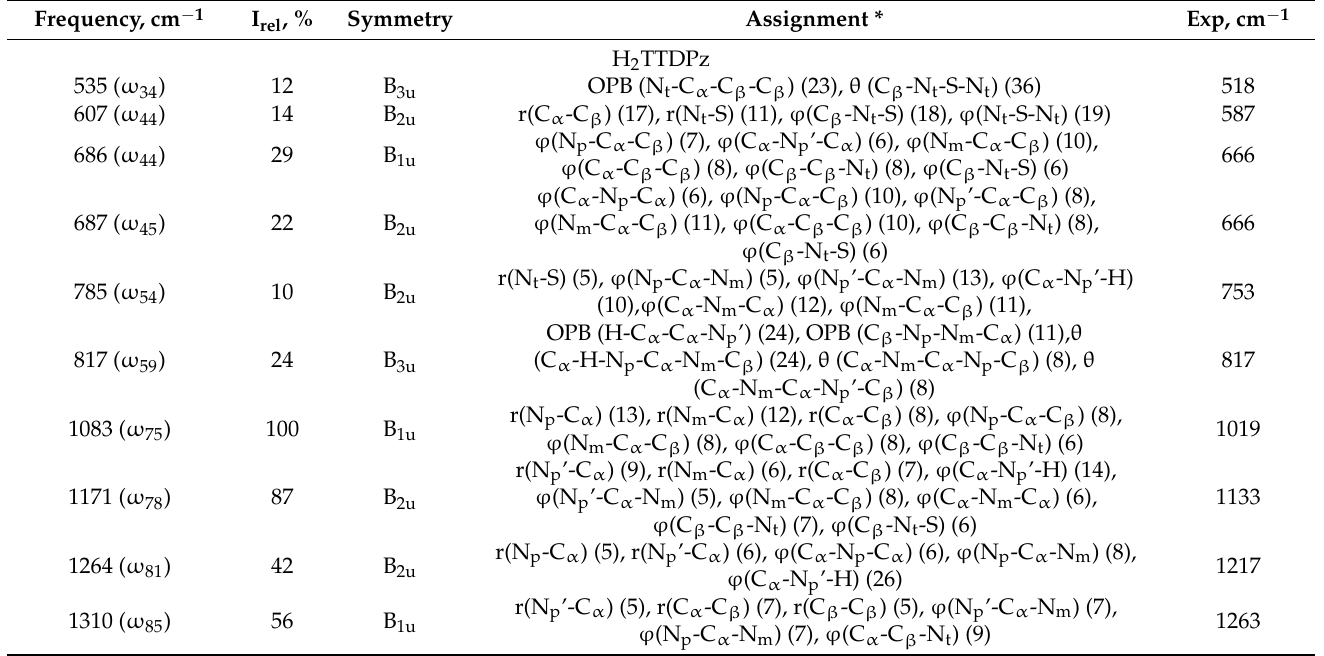
Table 6. Assignment of the IR vibrations of the H 2 TTDPz and NiTTDPz